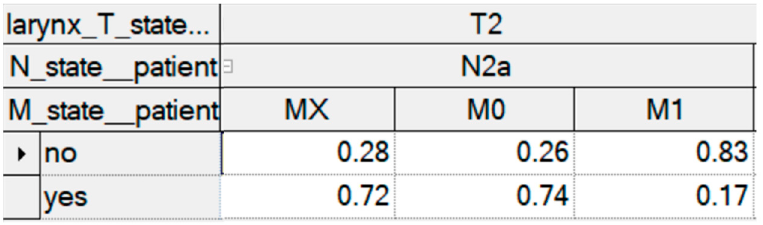
Figure 2. Probabilities of surgical therapy in the different TNM constellations.